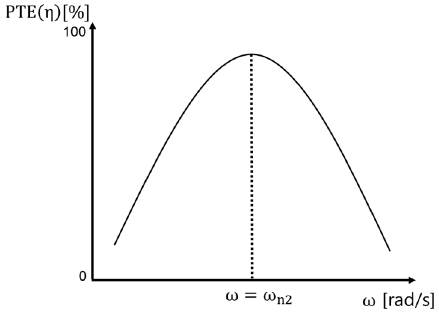
Figure 3. Schematic diagram of the power transfer efficiency of a WPT